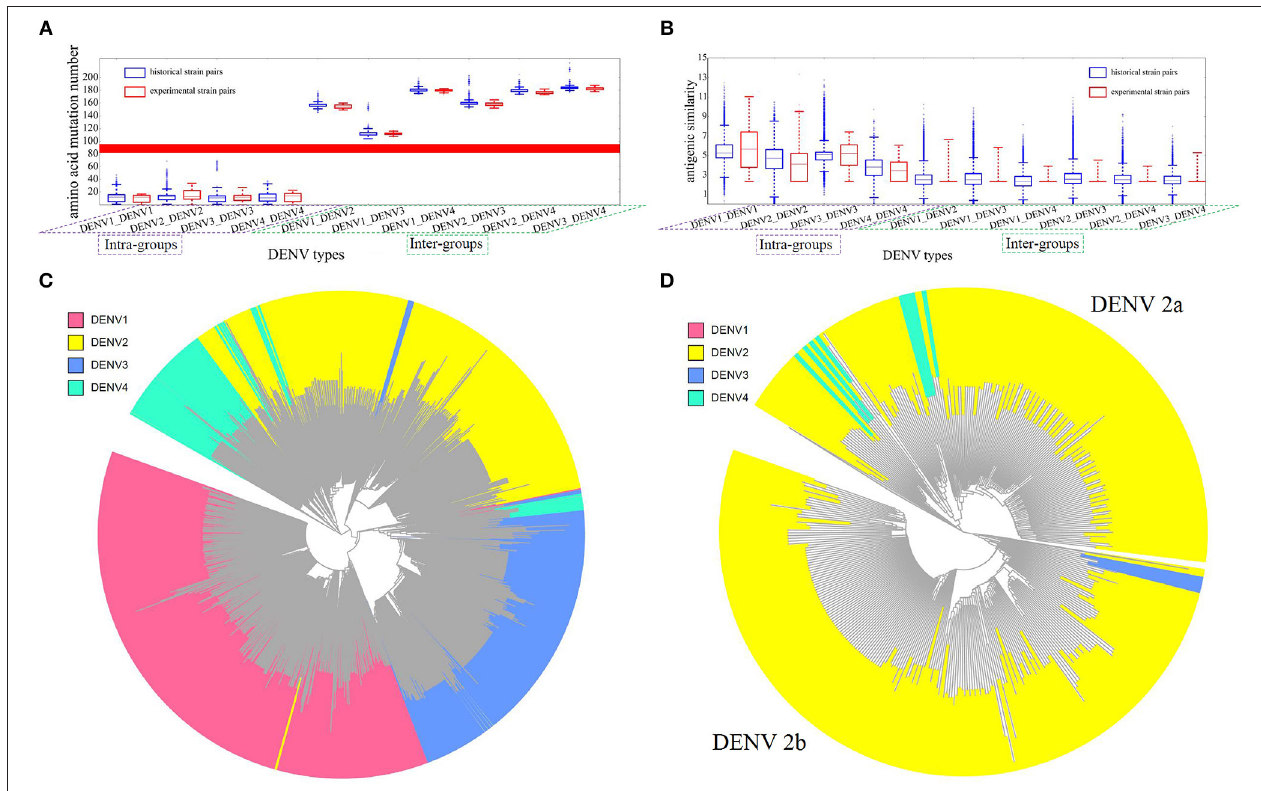
FIGURE 3 | Antigenicity and sequence analysis of DENV. (A) Genetic distance between intra- and inter-DENV serotypes by the number of residual mutations. Blue bars represent the results of 1,143 historical strains, red bars represent the experimental strains of 47 strains from Leah’s work (Katzelnick et al., 2015). X axis represents the four intra-groups and six inter-groups, Y axis represents mutation abundancy of compared strain pairs. (B) Antigenic similarity between intra- and inter- DENV strains. Blue bars represent the results of 1,143 historical strains, red bars represent the experimental binding results of 47 strains from Leah’s work (Katzelnick et al., 2015). X axis represents four intra- groups and six inter-groups. Y axis represents antigenic similarity of compared strain pairs, represented by logarithm of titer value. (C) Antigenicity clustering of 1,143 DENV strains, red, yellow, blue, and cyan represents DENV serotype 1, 2, 3, and 4, respectively. (D) Antigenicity clustering of two major clusters of DENV serotype 2, including DENV 2a and DENV